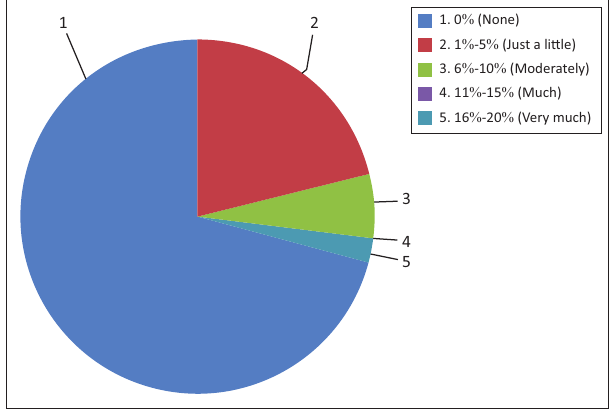
FIGURE 1: Extent of use of foreign labour in your business ( N = 151).